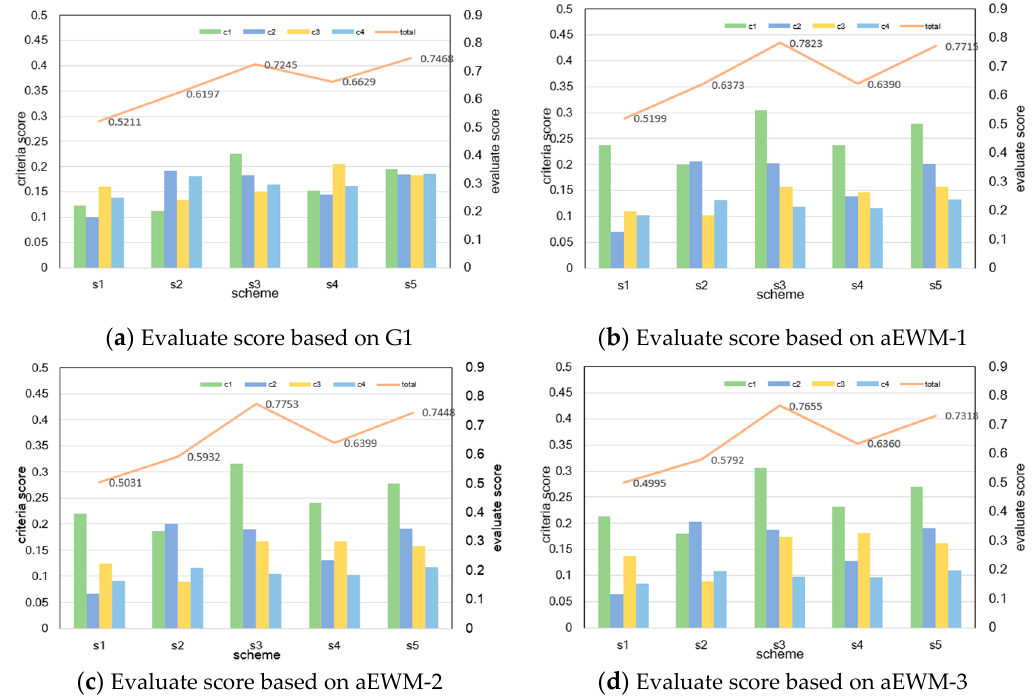
Figure 8. Evaluation scores based on G1 and aEWM